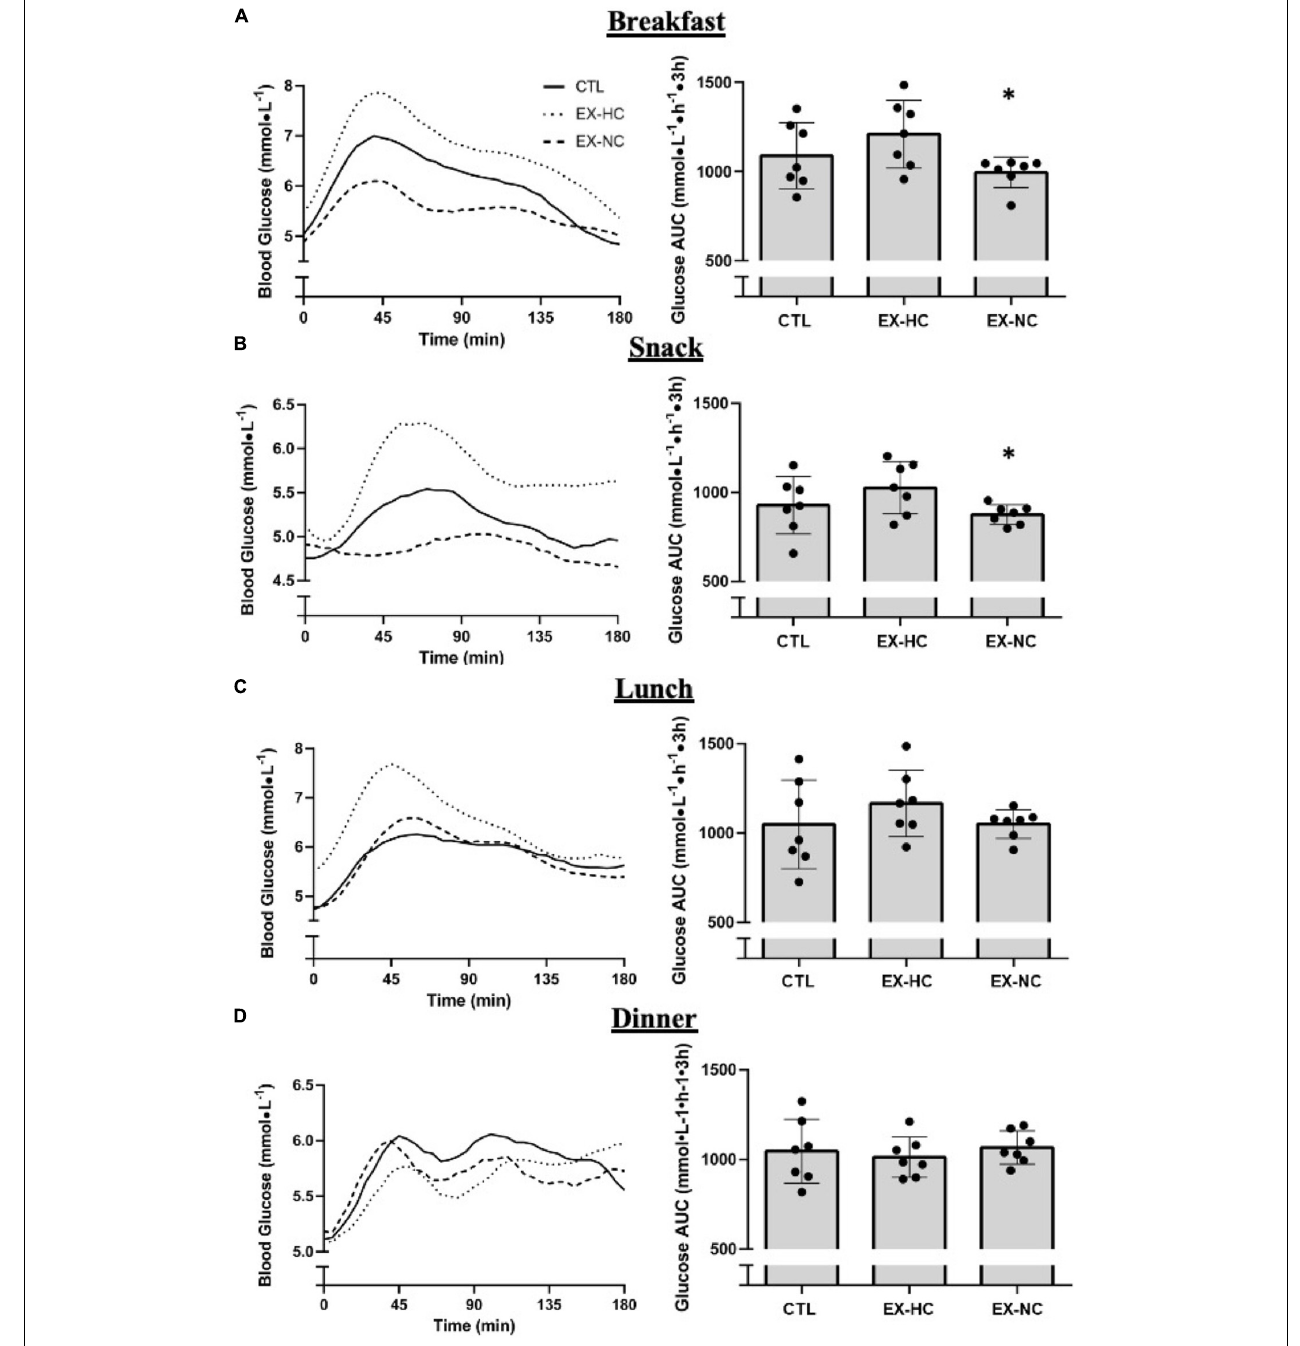
FIGURE 2 | Glycemic responses 3 h following breakfast (A) , snack (B) , lunch (C) and dinner (D) , measured the day following seated control (CTL) or a single session of HIIE with carbohydrate-energy replacement (EX-HC) or deficit (EX-NC). *Significant difference from EX-HC ( p < 0.05); Values are expressed as means ± SD .